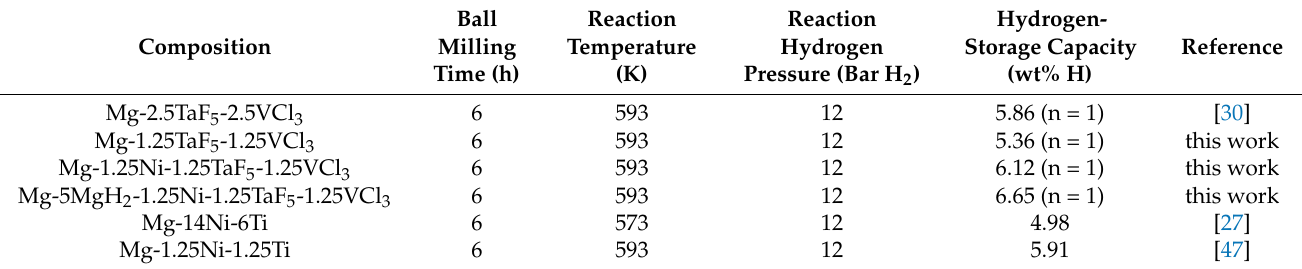
Table 3. Hydrogen-storage capacities of several Mg-based